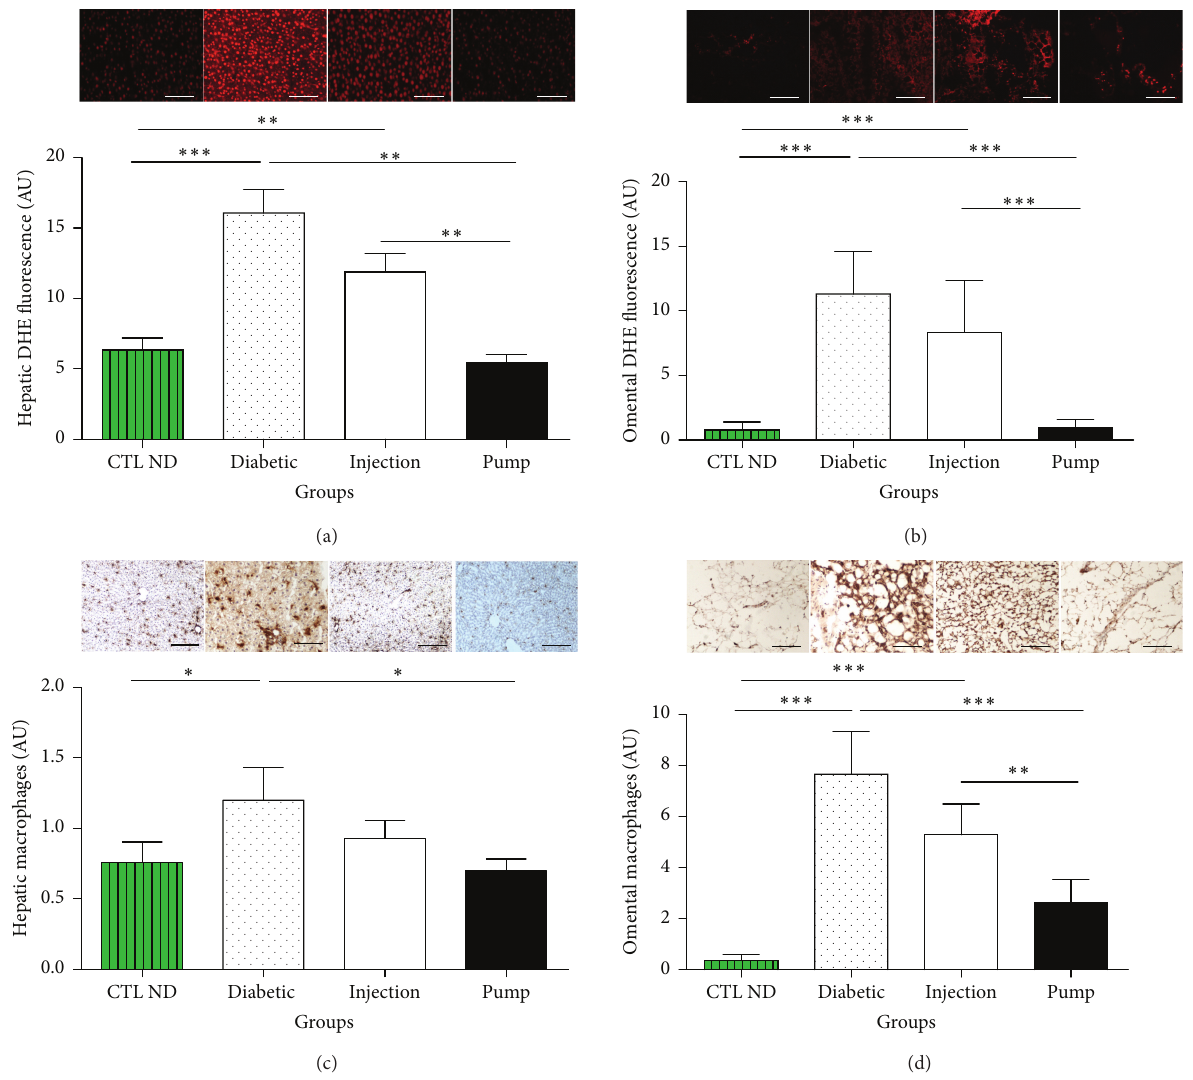
Figure 7: Reactive oxygen species (ROS) staining in liver (a) and omental tissue (b), macrophage staining in liver (c) and omental tissue (d), and their respective quantifications. The profiles were similar for all quantitative graphs, with diabetic rats having the highest level of oxidative stress or inflammation in both tissue sites. The control nondiabetic (CTL ND) and pump rats had the lowest level of ROS and macrophage staining. The injection group had lower levels than the diabetic group, but higher levels than the CTL ND or pump groups. ∗ 𝑝 < 0.05 , ∗∗ 𝑝 < 0.03 , and ∗∗∗ 𝑝 < 0.01 . Scale bar: 100 𝜇 m. DHE,